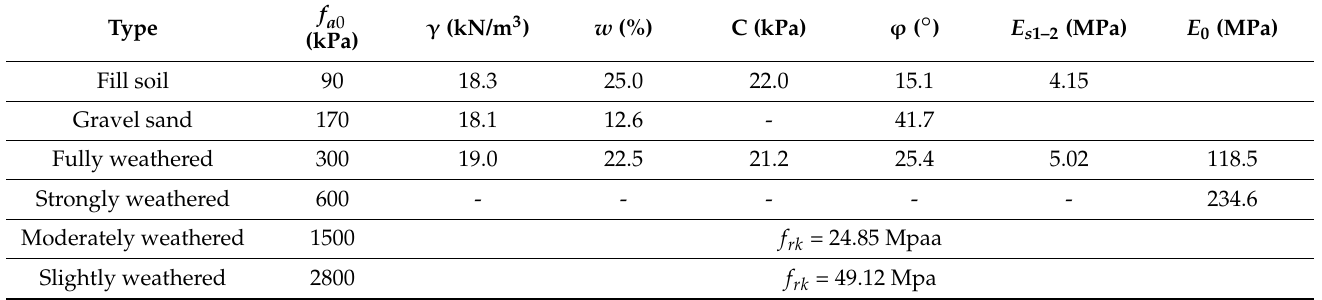
Table 1. Recommended values of geotechnical parameters of the soil layer.(the construction date from this project https://www.doc88.com/p-19259446047410.html?r=1, accessed on 18 May